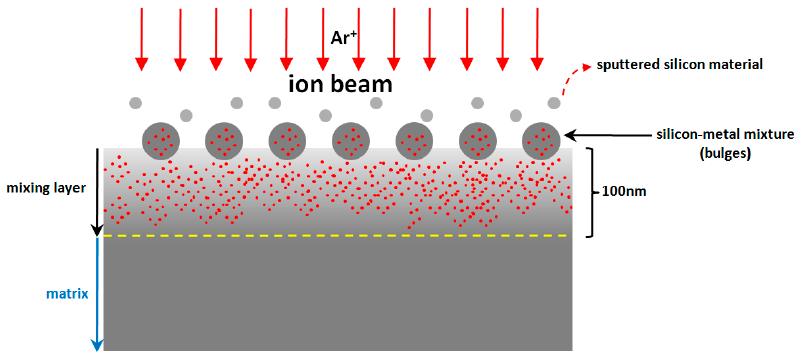
Figure 14. Two-phase model.